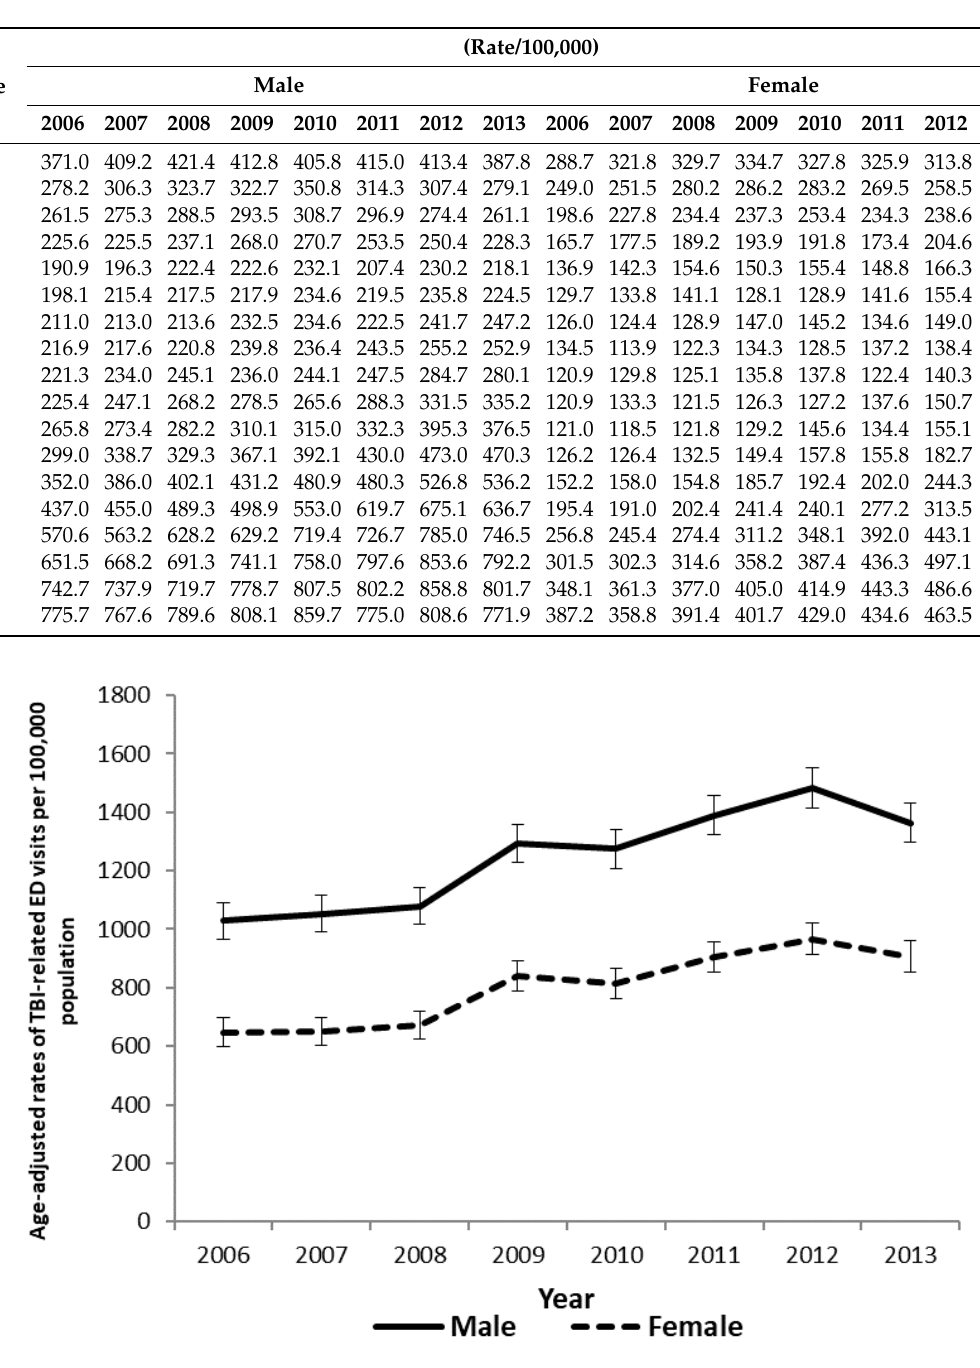
Figure 1. Age-adjusted rates of traumatic brain injury-related emergency department visits increased from 2006 to 2013 in both males and females in the U.S.